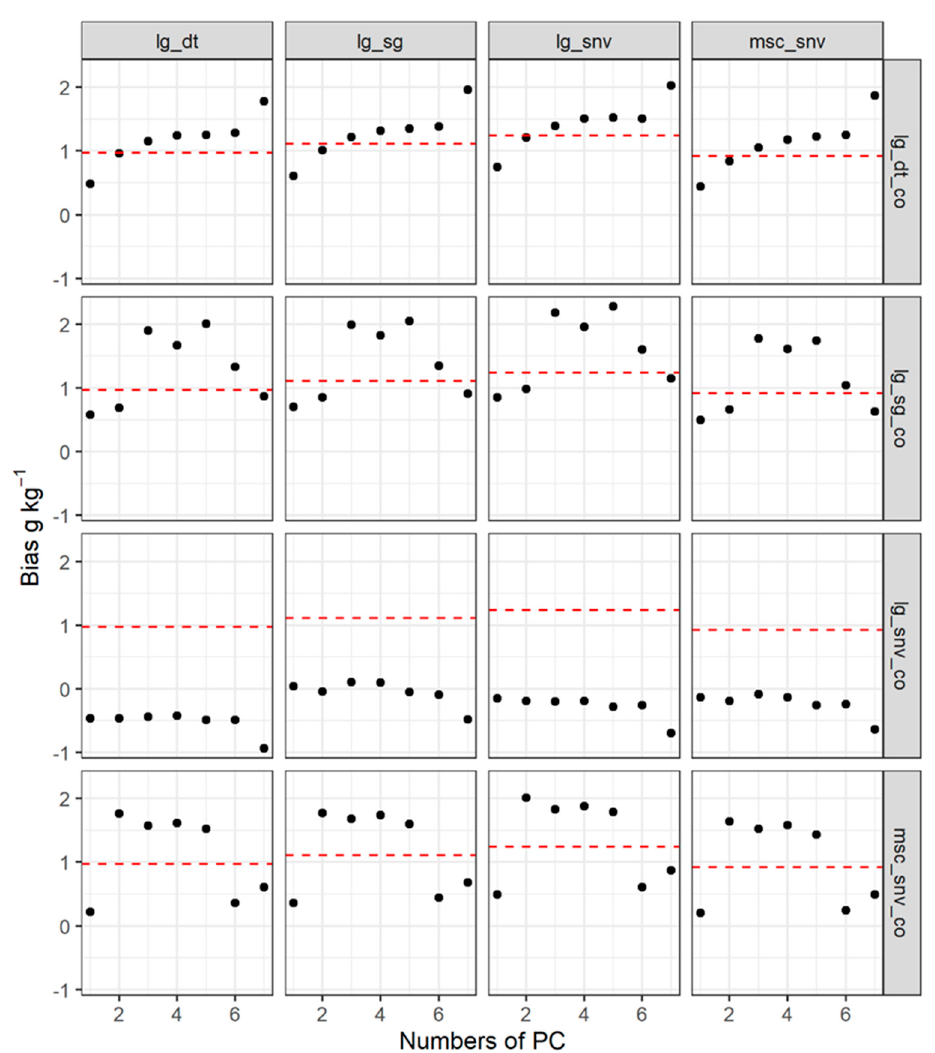
Figure 6. The bias calculated by the spatial model with four augmented data points and 7 PCs as covariates induced from the spectra under four preprocessing methods. Each column represents that the augmented data were the same, but PCs (as the covariate) were induced from the different preprocessing methods. Each row representing PCs (as the covariate) was the same, but the augmented data were induced from the different preprocessing methods. The red lines show the RMSE value without the spectra as the covariate in the corresponding column, and each column had the same bias.